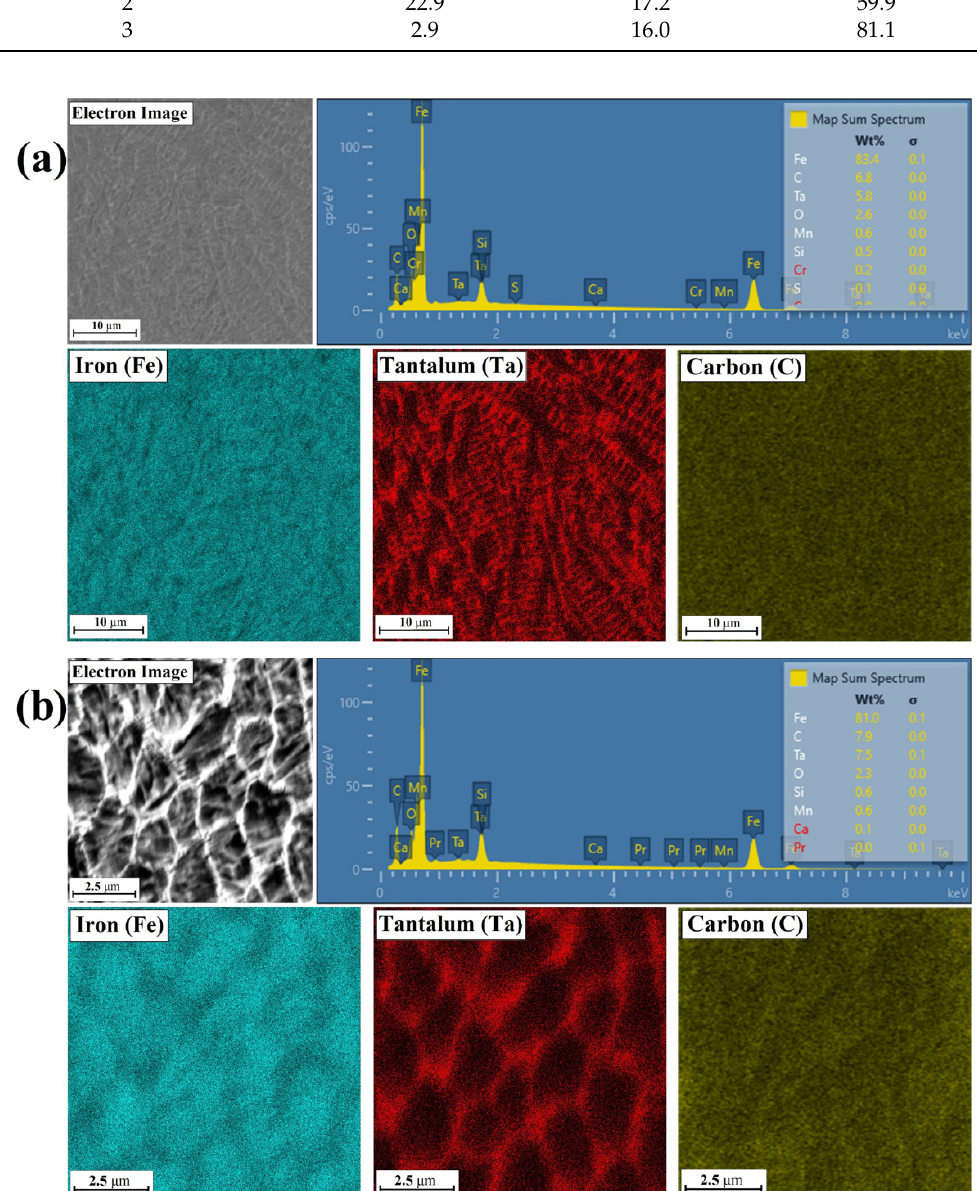
Figure 13. Chemical composition of middle area of the Fe/TaC coatings produced on tool steel using 30 µm thick pre-coat and laser beam power of 500 W ( a ), enlarging the examined area ( b ).